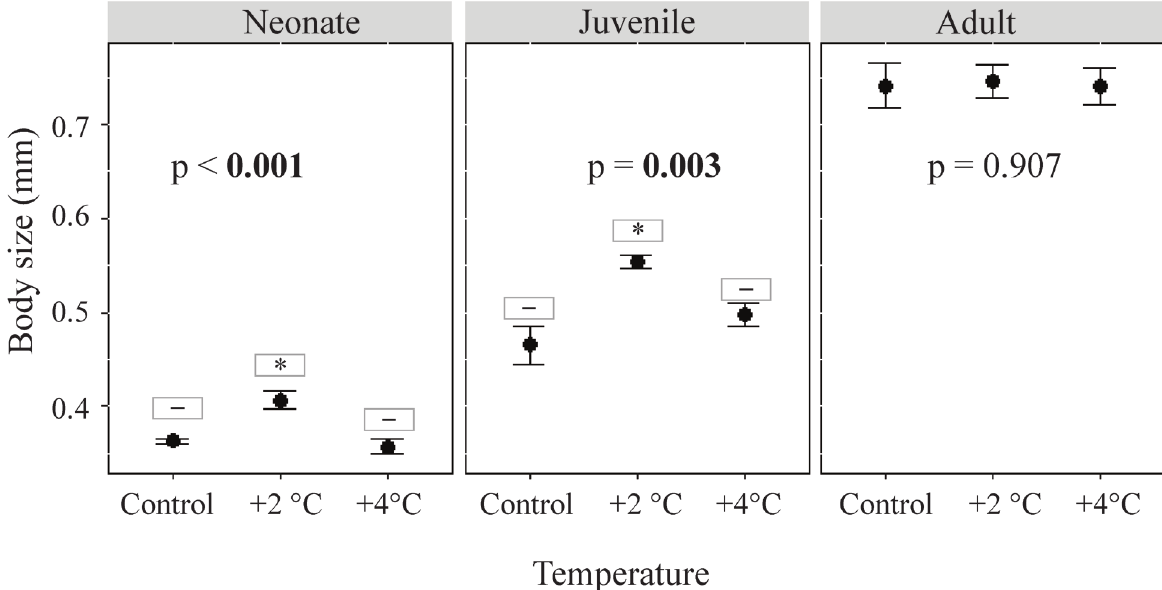
Figure 3. Box plot showing C. silvestrii body size (mm) in different development stages: neonate, juvenile, and adult (average from the three clutches) at three temperatures (control, +2, and +4°C), p-value from Kruskal-Wallis analyses are shown. Symbols(-,*) above the columns indicate significant differences in post-hoc analyses - treatments that share a symbol do not differ significantly, p >0.05. • indicates the mean, ± standard error bars are